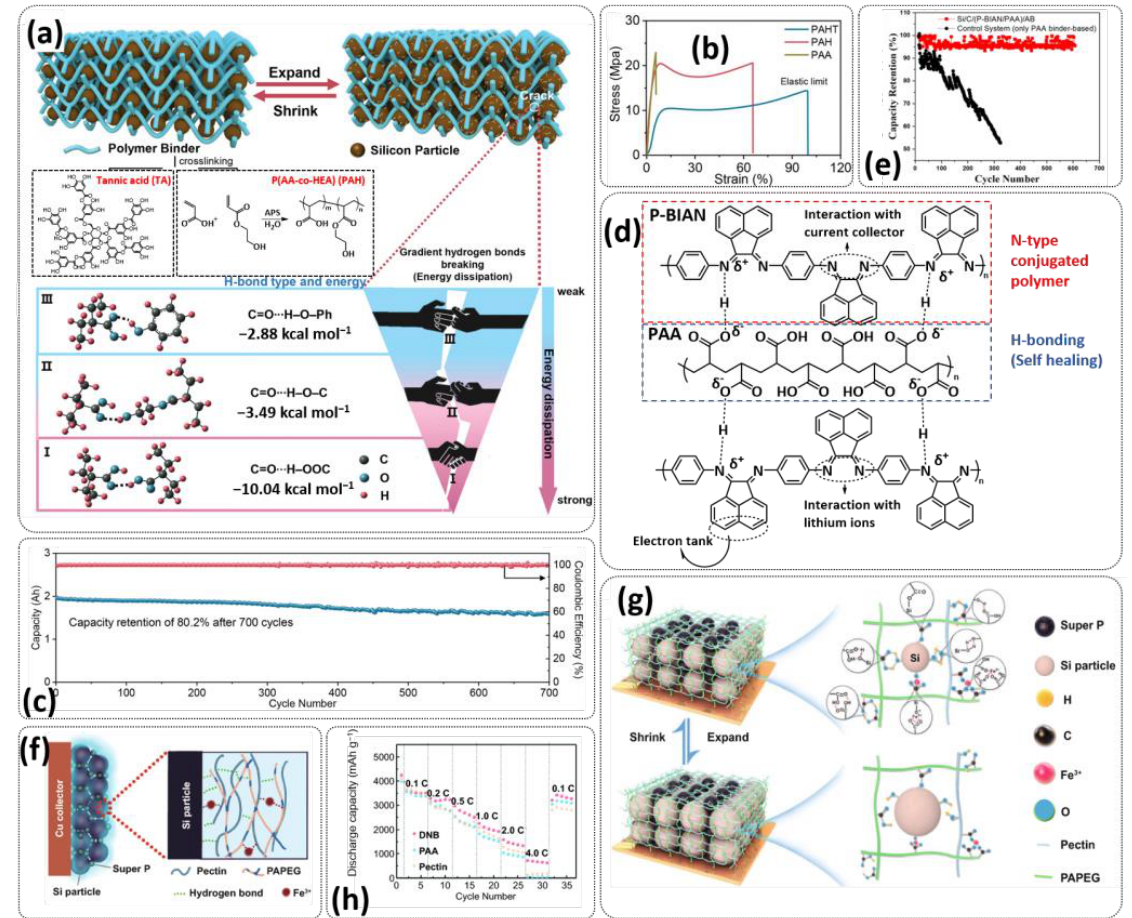
Figure 16. ( a ) Graphical representation depicting the expansion of the Si anode and the chemical structure of the gradient hydrogen-bonding binder (PAHT). Schematic illustration of the sequential energy-dissipation mechanism by this gradient H-bonding binder (PAHT) when the Si electrode expands. The hydrogen bond types and bond energies calculated by density functional theory simulations. The order of the gradient hydrogen bonds breaking is from weak to strong. ( b ) Stress– strain curves of the PAA, PAH and PAHT films. ( c ) Cycling performance of the NCM/Si-C full pouch cell at 1C between 2.75 and 4.2 V. Reproduced with permission from [149]. Copyright © 2021 Wiley-VCH GmbH. ( d ) Design strategy of the P-BIAN/PAA composite. ( e ) Comparison of the capacity retention of the Si/C/(P-BIAN/PAA)/AB anode with a control system with only PAA binder. Reproduced with permission from [146]. Copyright © 2022, American Chemical Society. ( f ) Design of the bioinspired double-network polymer binder DNB. ( g ) The supramolecular hybrid network in Si electrodes during cycling. ( h ) Rate capability of the Si (1.0 mg cm −2 )/Li cells with different binders at different current rates. Reproduced from [147].